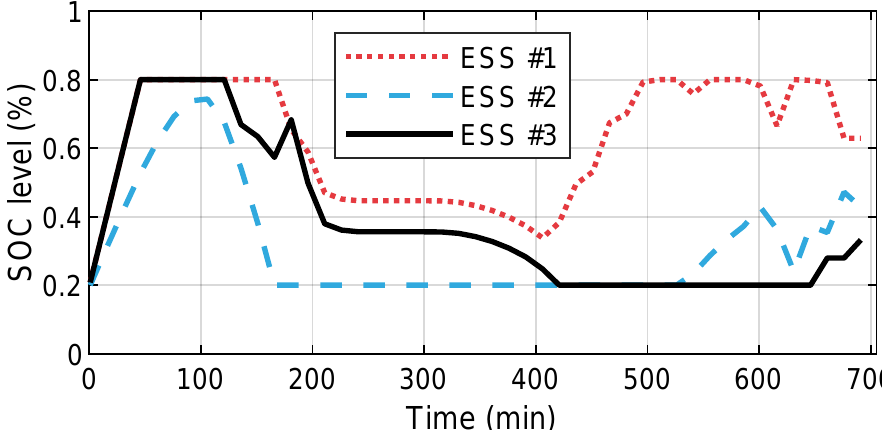
Figure 8. The change of each ESS’s SOC using greedy method.